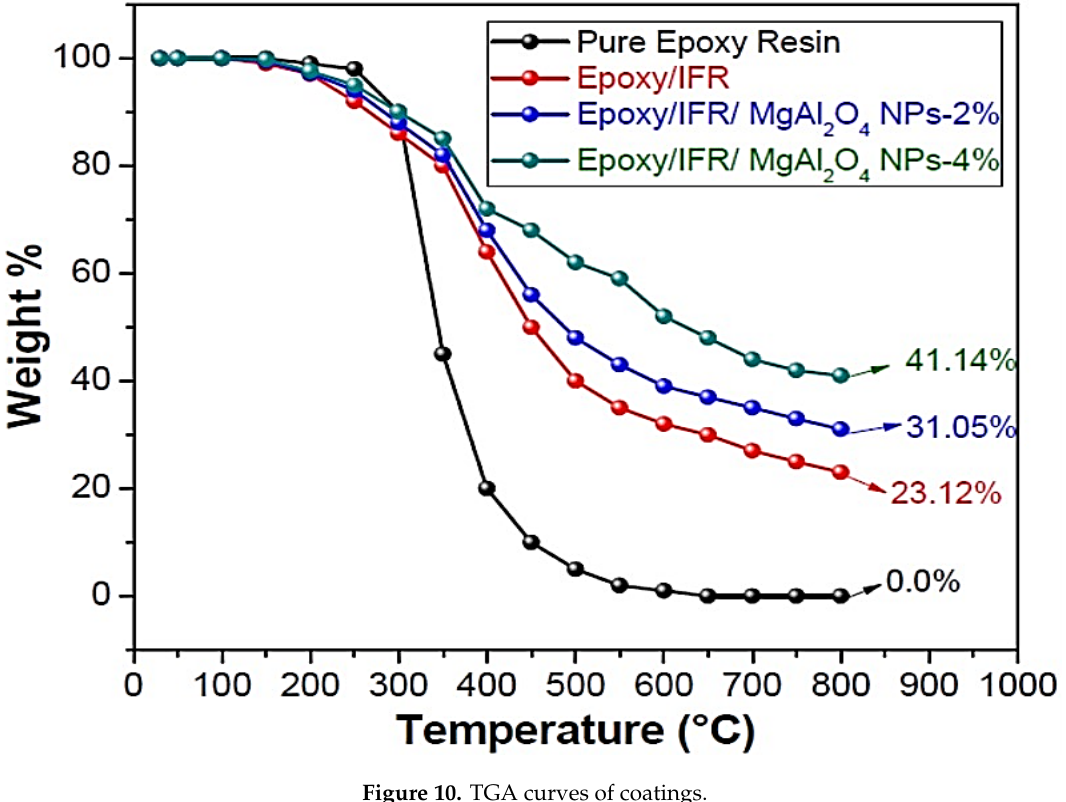
Figure 10. TGA curves of coatings.